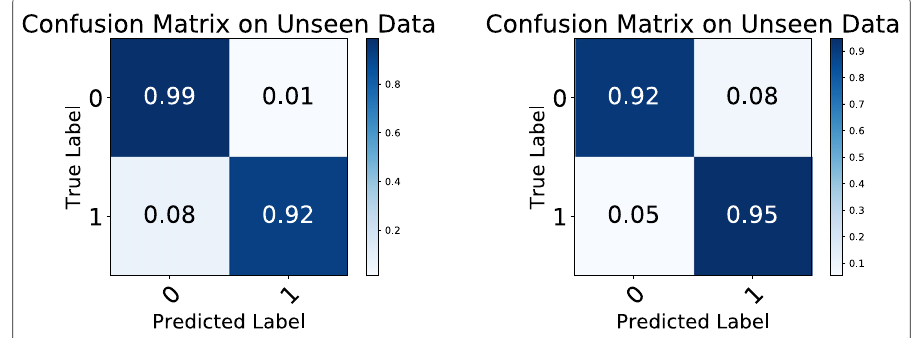
Fig. 6 Confusion Matrix of Machine Learning Model (unseen data). IBM (left) and Samsung